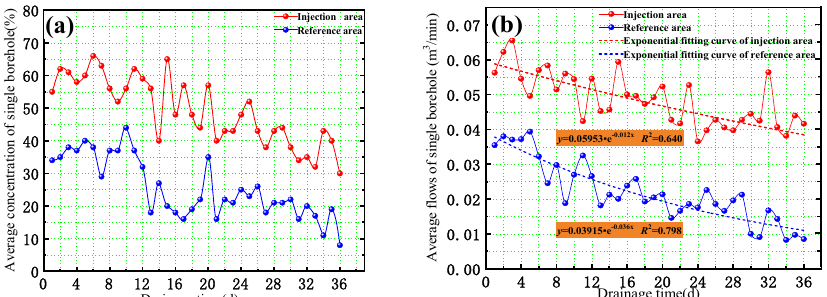
Figure 14. Gas drainage quantity of the drainage boreholes. ( a ) Average concentration of single borehole, ( b ) Average flow of single borehole